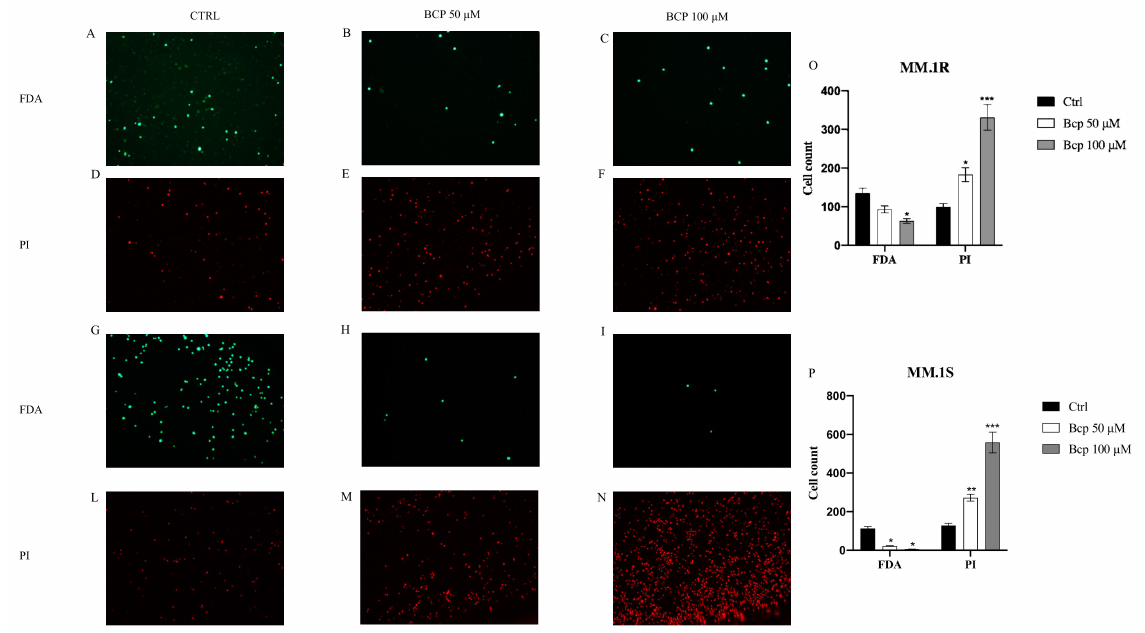
Figure 2. The figure represents the apoptotic process evaluated by FDA/PI staining in MM.1R and MM.1S cell lines treated with BCP. In panels ( A – C ) and ( G – I ), green color reaction indicates viable MM.1R and MM.1S cells, respectively; in panels ( D – F ) and ( L – N ), red reaction indicates MM.1R and MM.1S cells that underwent apoptosis, respectively. Panels ( O ) and ( P ) show the cells counts in MM.1R and MM.1S. The data are expressed as means ± SEM; n = 3 experiments; * p < 0.05 vs. Ctrl. ** p < 0.001 vs. Ctrl. *** p < 0.0001 vs.